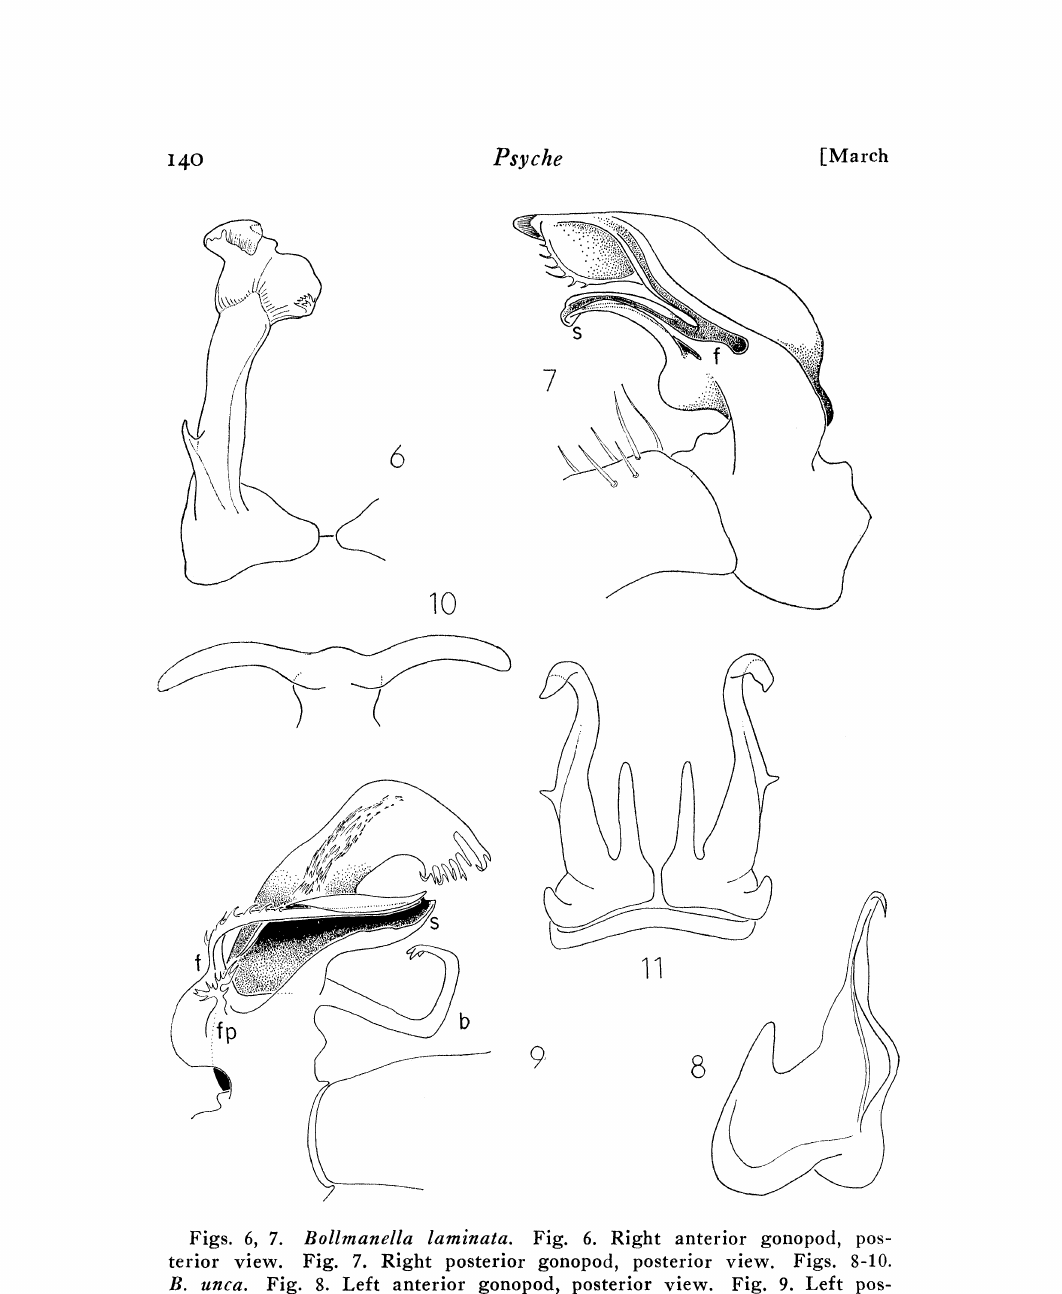
Figs. 6, 7. Bollmanella laminata. Fig. 6. Right anterior gonopod, pos- terior view. Fig. 7. Right posterior gonopod, posterior view. Figs. 8-10. B. unca. Fig. 8. Left anterior gonopod, posterior view. Fig. 9. Left pos- terior gonopod, posterior view. Fig. 10. Sternal process between posterior gonopods. Fig. 11. Anterior gonopods of B. bi[urcata, posterior